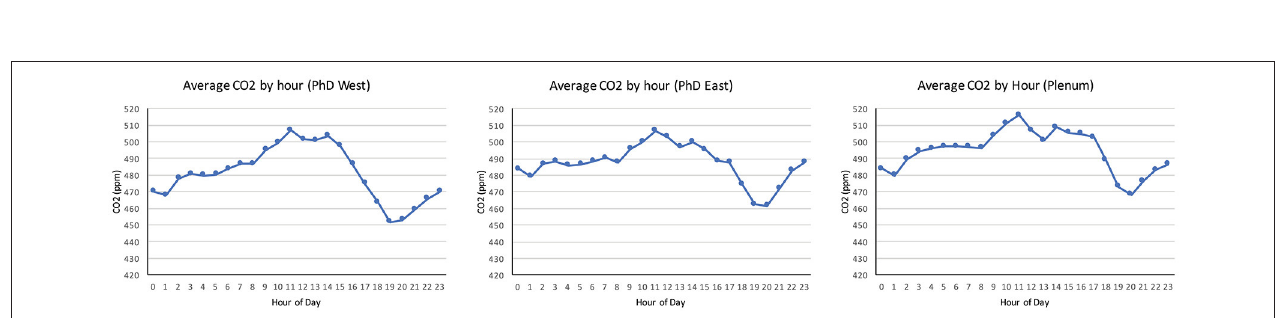
FIGURE 8 | Average hourly CO 2 levels in the graduate office of ACEE, for the whole experimental period.